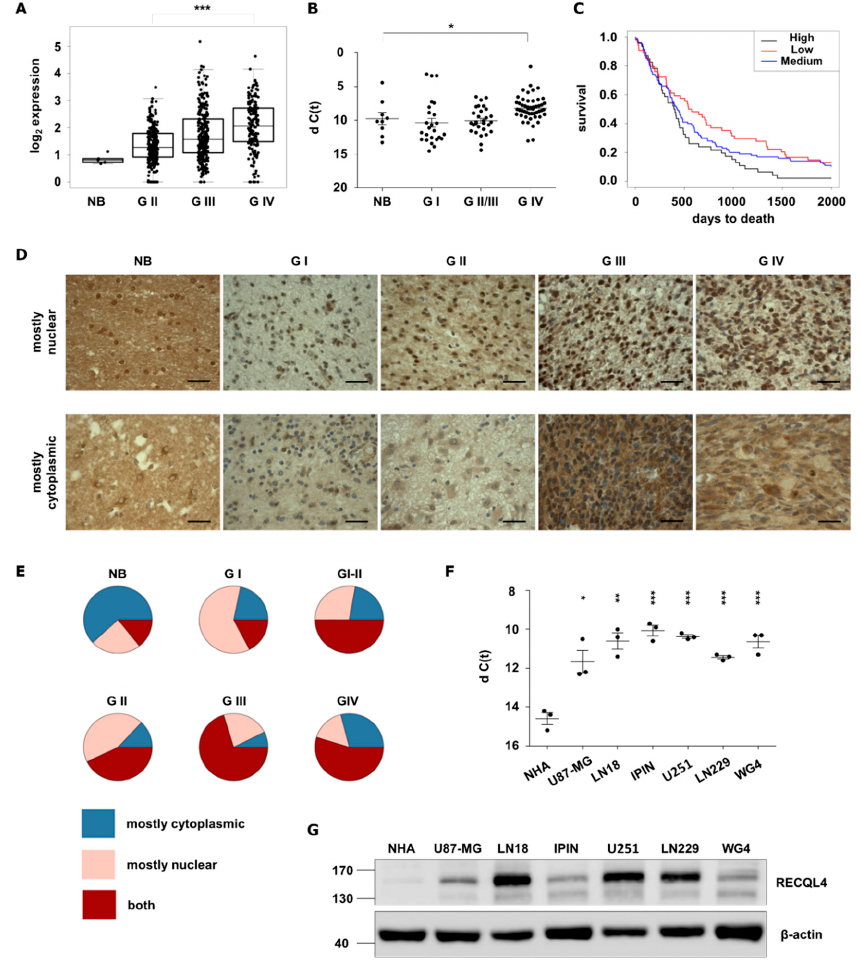
Figure 1. RECQL4 expression is upregulated in human malignant gliomas. ( A ) RECQL4 expression in normal brain (NB), WHO grade II and grade III gliomas and glioblastomas (GBM, WHO grade IV) in TCGA datasets. Presented values are log 2 of FPKM values. Statistical significance was determined by Welch’s analysis of variance (ANOVA) between GII, GIII and GIV groups. ( B ) Quantitative analysis of RECQL4 mRNA levels in NB ( n = 9), and gliomas of di ff erent grades: GI ( n = 25), GII / III ( n = 29) and GBM ( n = 50). The RECQL4 expression was normalized to GAPDH ; results represent means ± SEM; statistical significance was determined by one-way ANOVA, followed by Dunnett’s post hoc test. p -Values were considered as significant when * p < 0.05. ( C ) Kaplan–Meier overall survival analysis of LGG and GBM patients from TCGA. Log-rank test was calculated between RECQL4 LOW and HIGH expression groups (* p < 0.05). ( D ) Representative immunostaining showing expression of RECQL4 protein in the glioma tissue microarray including astrocytomas ( n = 132), glioblastomas ( n = 31), oligoastrocytomas ( n = 7), oligodendrogliomas ( n = 9), ependymomas ( n = 11), ganglioglioma ( n = 1) and gliosarcoma ( n = 1), plus tumour adjacent and normal brain (NB) tissues ( n = 8). RECQL4 expression appeared as high nuclear and low cytoplasmic signal (upper panel) and low nuclear and high cytoplasmic signal (bottom panel). ( E ) Quantification of RECQL4 immunoreactivity. Statistical significance was determined by chi-squared test. p -values of NB p = 1.0, GI p = 0.019, GII p = 1.1 × 10 − 5 , GIII p = 6.3 × 10 − 5 , GIV p = 0.011. ( F ) Quantitative analysis of RECQL4 mRNA levels in established glioma cell lines, patient-derived primary cultures, and normal human astrocytes (NHA). The expression was normalized to GAPDH ; results represent means ± SEM of 3 cell passages ( n = 3). Statistical significance was determined by one-way ANOVA. p -Values were considered as significant when * p < 0.05, ** p < 0.01, *** p < 0.001. ( G ) Representative immunoblot shows RECQL4 expression in established glioma cell lines and GBM primary cultures in comparison to NHA. β -Actin was used as a loading